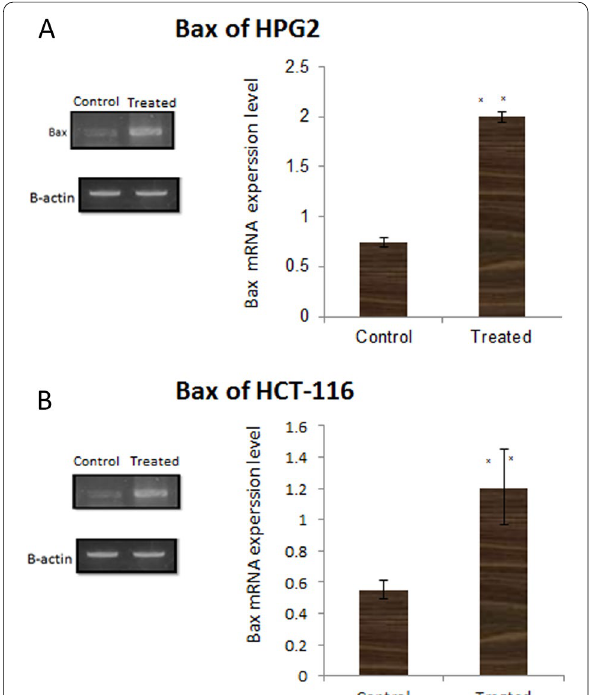
Fig. 5 PCR detected the expression of Bax in HepG2 and HCT‑116 cells after treatment with NSP where the internal control expressed by the β‑actin gene. In each illustrative experiment data represent means SE performed in triplicate. *represents significantly dissimilar ± results (P < 0.05)